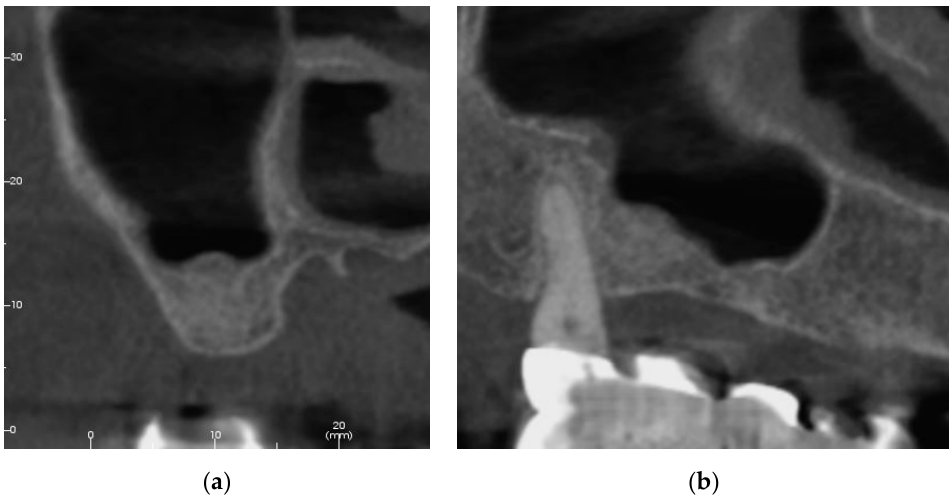
Figure 7. Patient #2. Postoperative CBCT cross-section image of the first molar area showing regular remodeling of the gel graft into new bone with vertical available ridge height of 8.6 mm ( a ). No radiographic evidence of disseminated residual biomaterial was observable in the Panorex view, with sinus membrane showing no signs of hypertrophy or inflammation ( b ). with sinus membrane showing no signs of hypertrophy or inflammation ( b